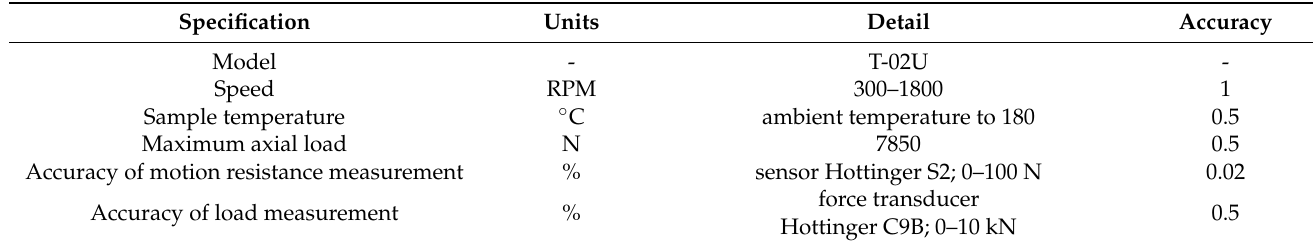
Table 2. Technical data of the four-ball